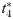
Timing varies as the FFT frame interval changes.Here we show results for the ideal detector and the LabVIEW and Swift+serial implementations, for the constructed δ-syllable and for trigger t4* of lny64’s song. The lines show latency; error bars are standard deviation (jitter). Points have been shifted horizontally slightly for clarity; original positions are [0.5 1 1.5 2 4] ms.